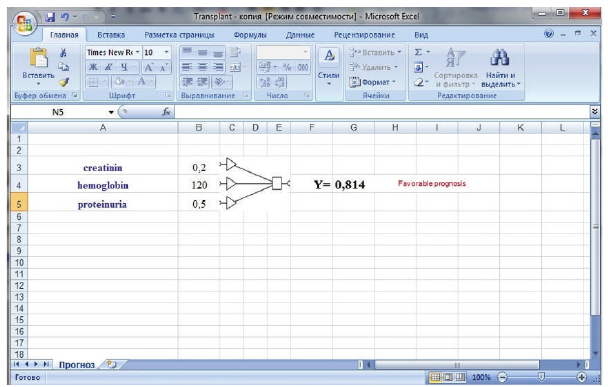
Figure 3: The interface of mathematical model for prognostication of kidney transplant function during the period of three years after the transplantation according to the results of investigation one year after the